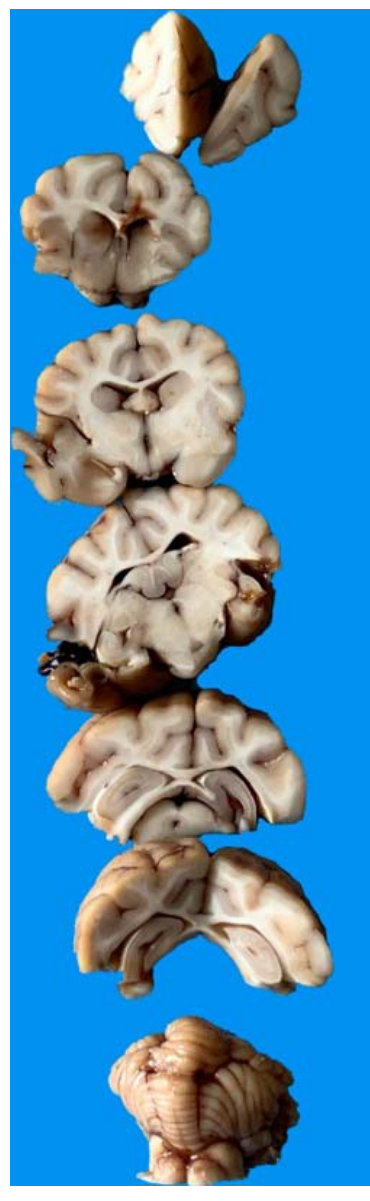
Figure 1. Representative image of a harvested red fox’s brain necropsied and cut through the coronal plane from the frontal ( top ) to the cerebellum ( bottom ).